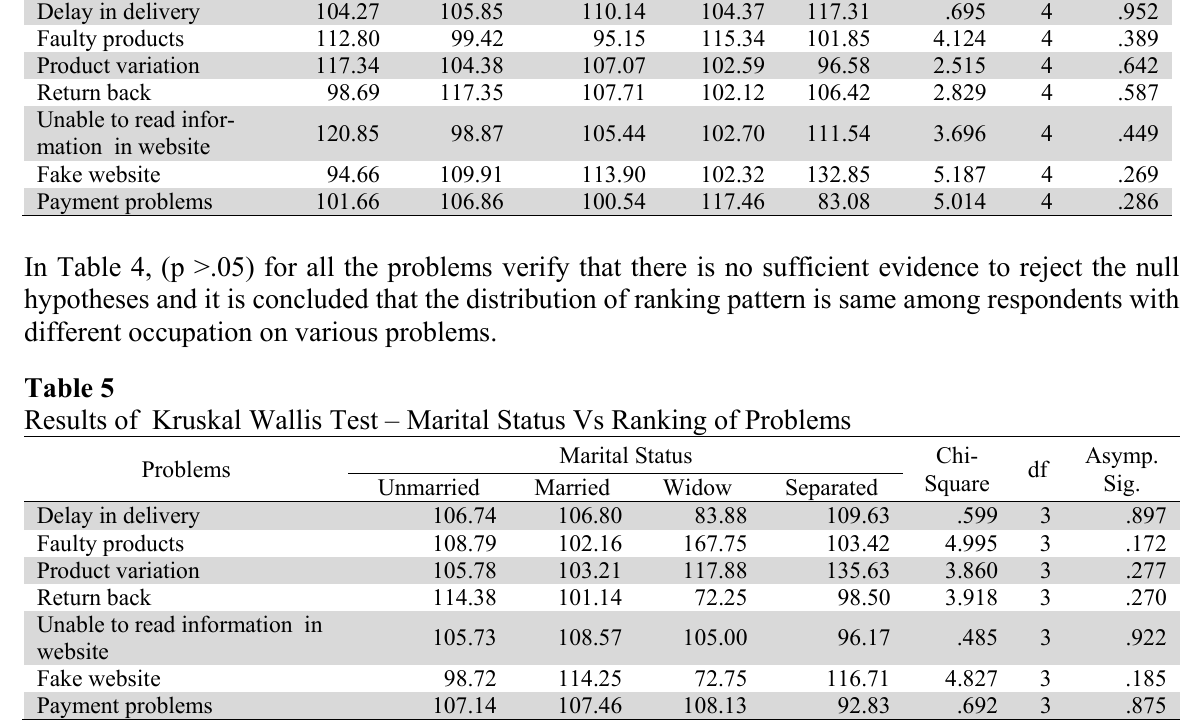
Results of Kruskal Wallis Test - Occupation Vs Ranking of Problems Problems